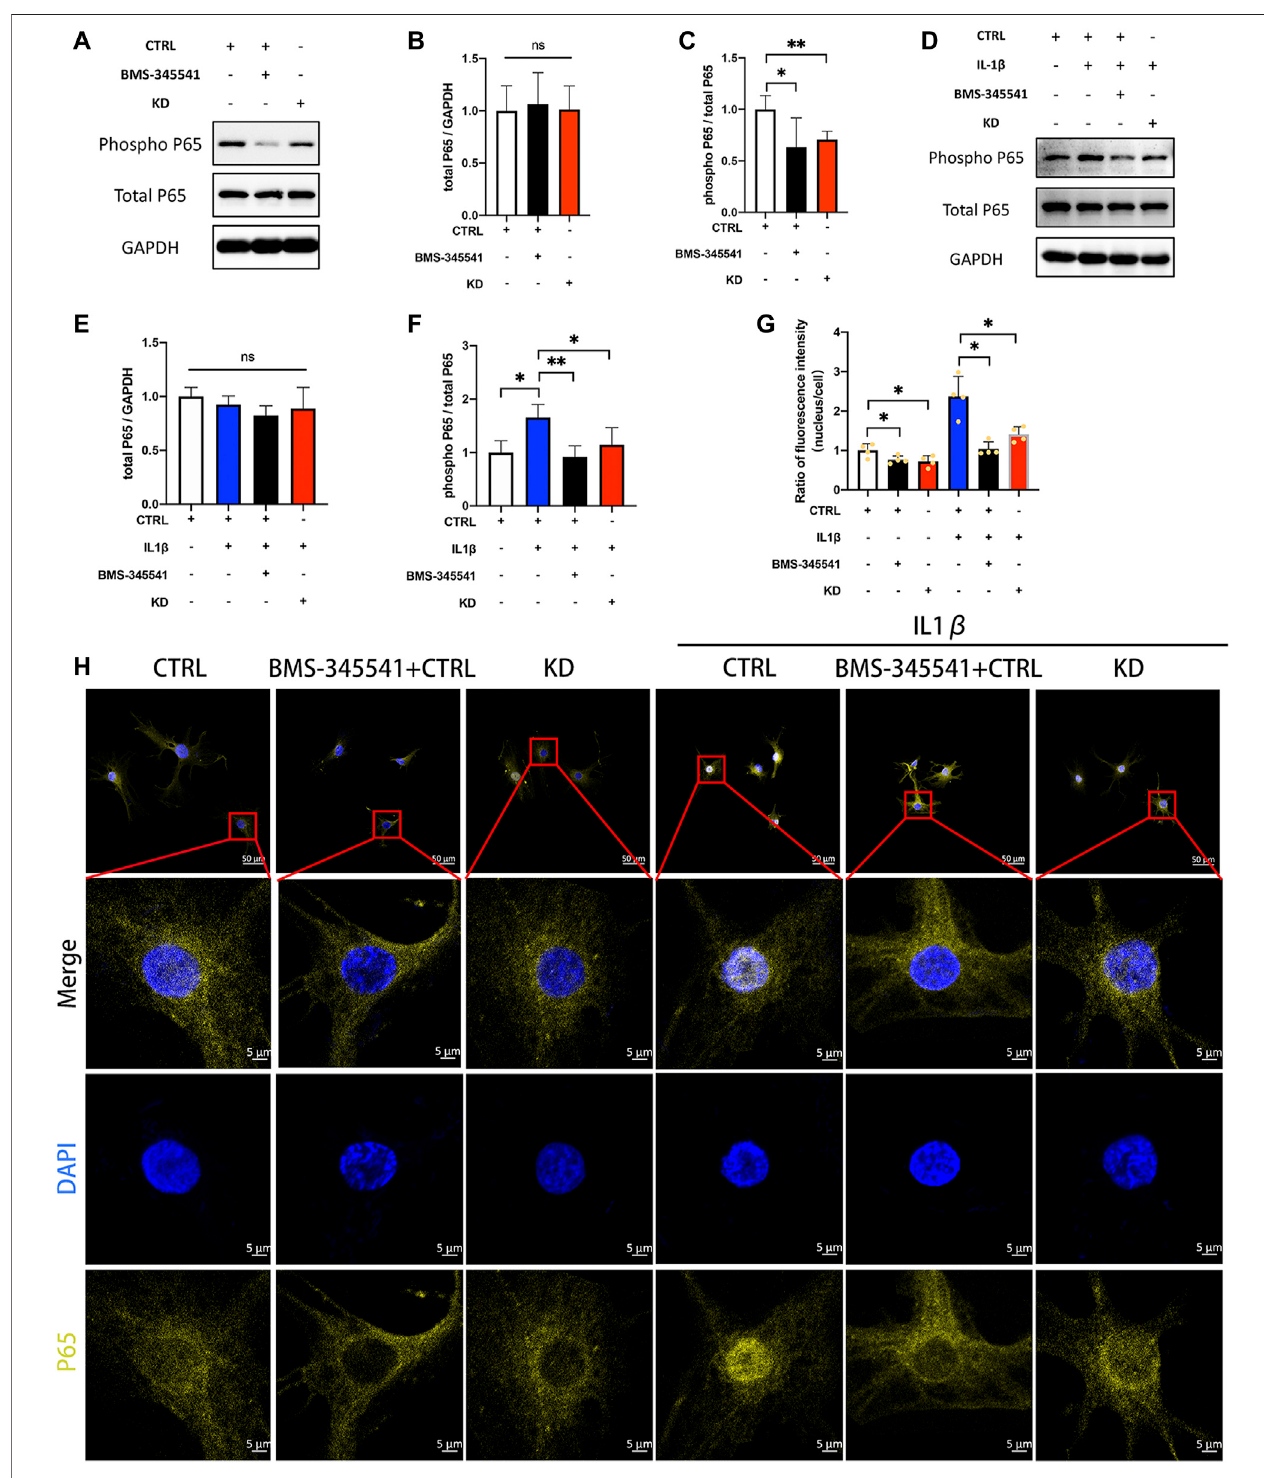
FIGURE7| KnockdownofLINC02569attenuatedNPCsdegenerationbyblockingNF- κ Bsignalingpathway. (A – C) ProteinlevelsoftotalP65andphosphorylated P65determinedbyWBanalysesoflysatesfromLINC02569knockdownNPCsorNPCstreatedwithBMS-345541(NF- κ Binhibitor). (D – F) ProteinlevelsoftotalP65and phosphorylated P65 determined by WB analyses of lysates from LINC02569 knockdown NPCs or NPCs treated with BMS-345541 and IL-1 β . (G – H) Representative immuno fl uorescenceimagesoftotalP65inNPCsfromdifferentgroups.Quantitativeresultsarefrom3independentexperimentsandareshownasthemean ± SD. p p < 0.05, pp p < 0.01.